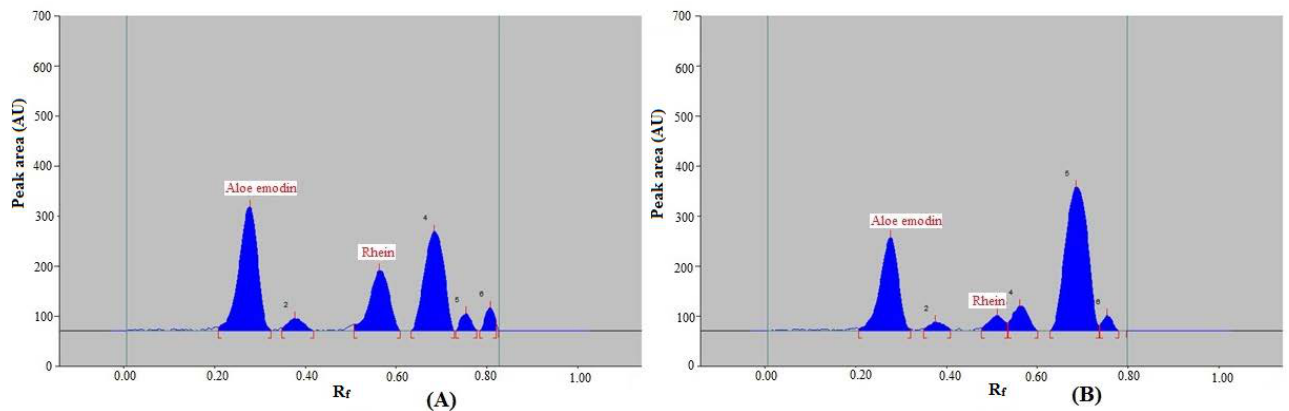
Figure 7. Conventional normal-phase HPTLC densitograms of rhein and aloe-emodin in ( A ) UBE of marketed Rhubarb extract and ( B ) UBE of Rhubarb plant extract.